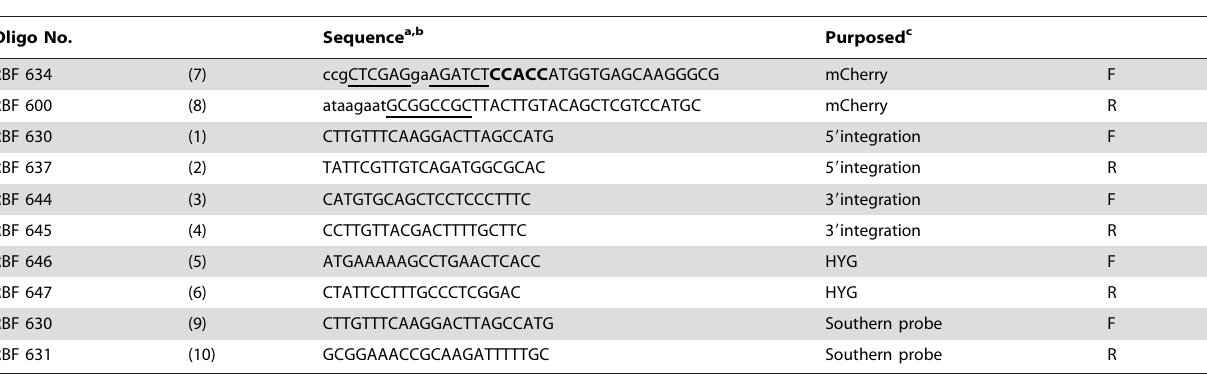
a Underlined sequence indicates restriction site. b Bold sequence indicates optimized translation initiation sequence. c Orientation of primers: F, forward; R, reverse.